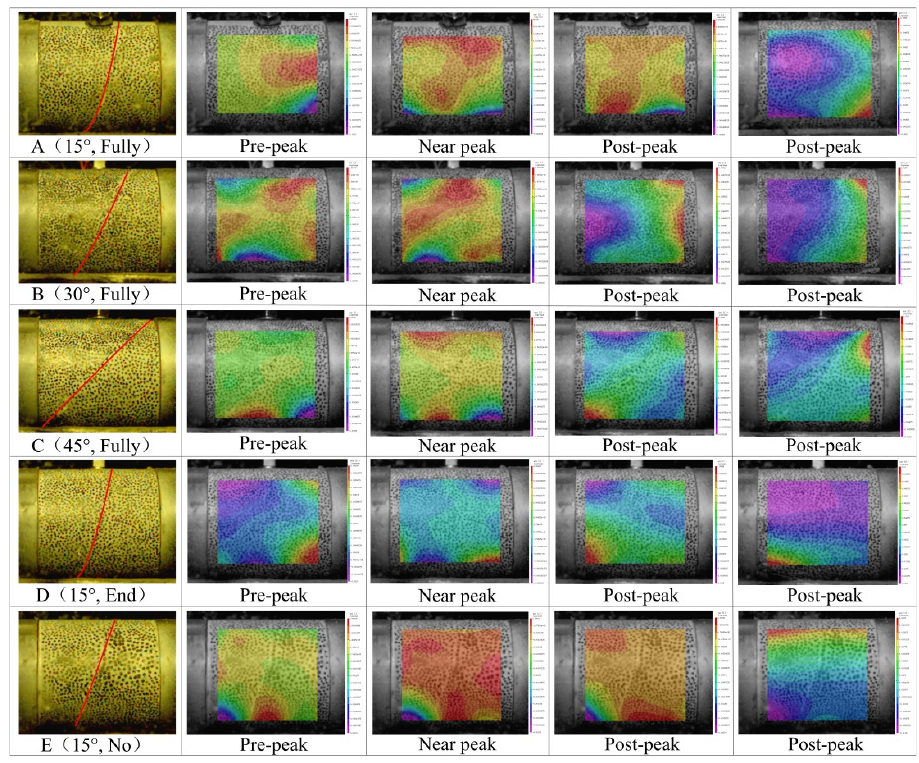
Figure 10. y ‐ direction nephogram of the dynamic load response of an anchorage